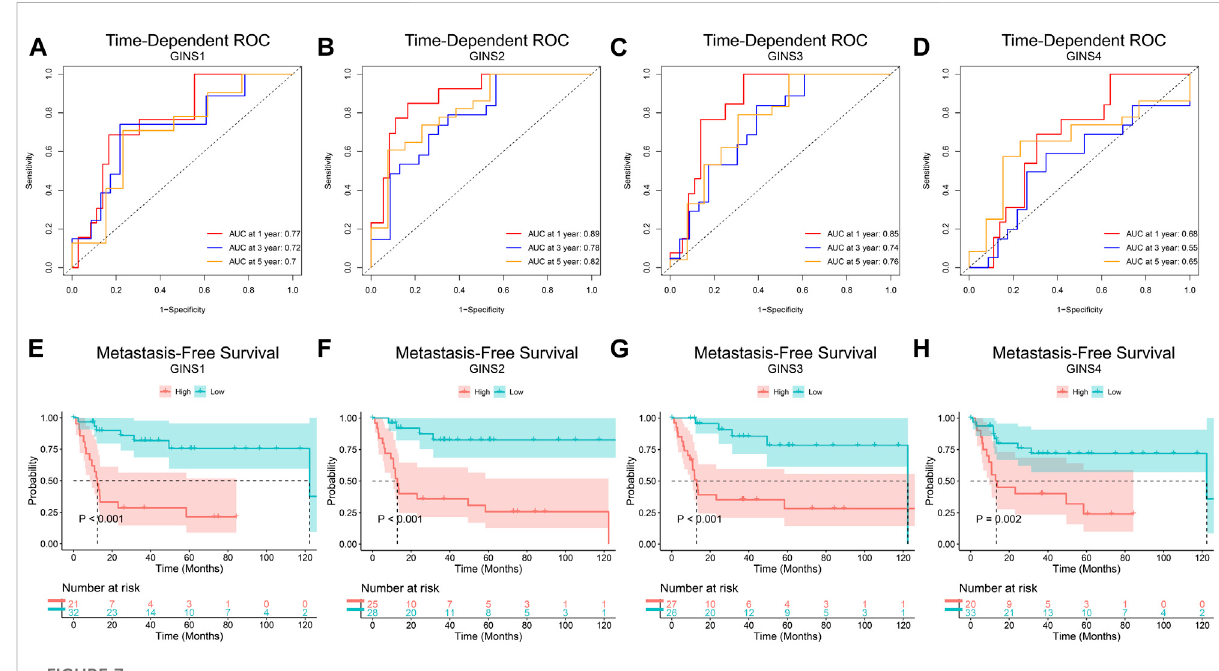
FIGURE 7 The prognostic value of GINS subunits in sarcoma patients (GSE40021 dataset). Time-dependent ROC curves of GINS1/2/3/4 in SARC (A – D) . MFS curves of GINS1/2/3/4 in SARC (E – H)